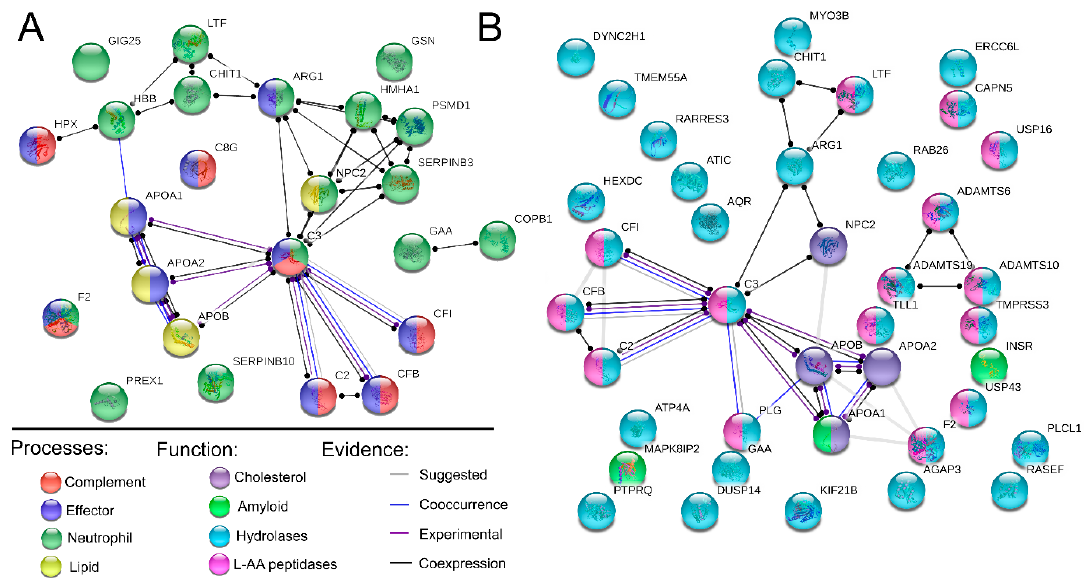
Figure 5. STRING pathway analysis. Analysis of non-IgG proteins and peptides found in significantly elevated levels in BALF of sarcoidosis patients following FDR correction. ( A ) Significantly elevated biological processes. ( B ) Significantly elevated proteins of a specific molecular function. Network links are shown according to evidence mode. For more details see Table 1. AA; amino acid. The gene name abbreviations are given in the Abbreviations.